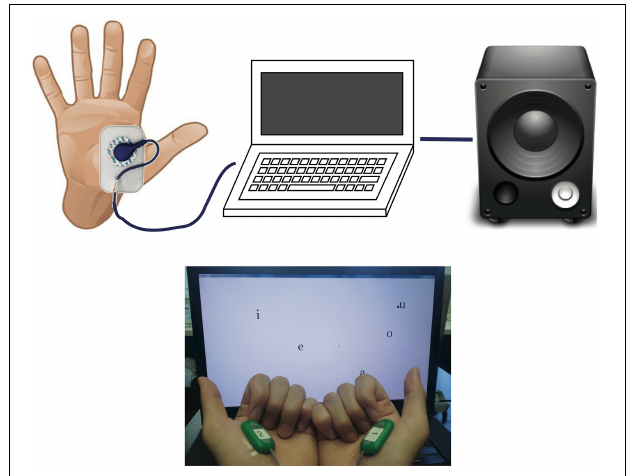
FIGURE 1 | Design of the system (top) and a snapshot of the working set-up (bottom). The EMG electrodes are placed on the flexor pollicis brevis muscles of both hands. Pinching the thumb and index finger will activate the EMG to move both the screen cursor and formant frequency.